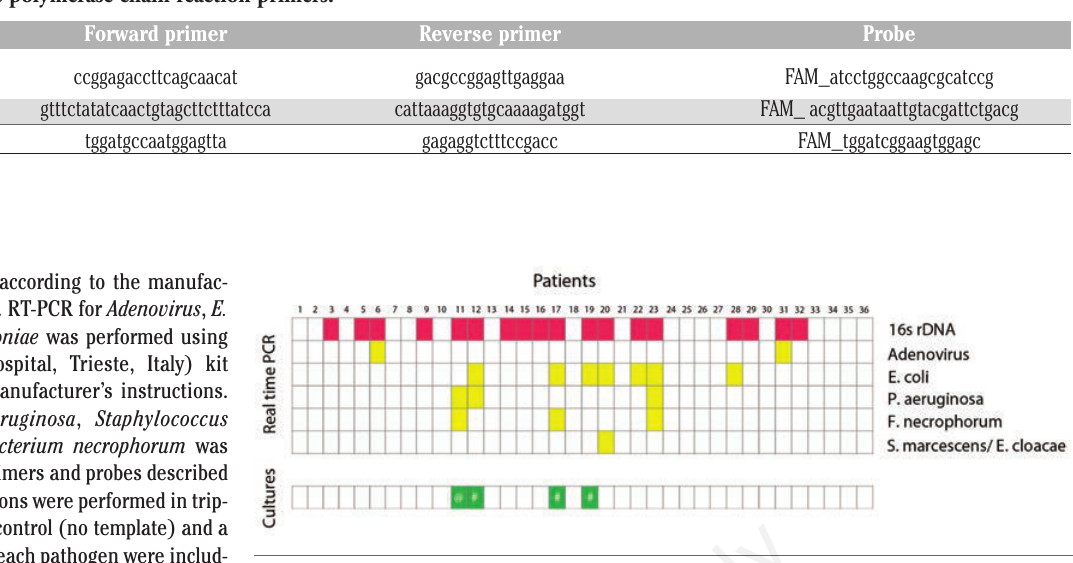
Figure 1. Results of real-time polymerase chain reaction (RT-PCR) analysis and cultures of specimens from 36 patients. Positive results are marked as blank squares. In three cul- tures (patient 12; 17; 19) grew E. coli at (#), in another one (patient 11) P. aeruginosa and B. ovale (@). Samples from these four patients resulted positive both to RT-PCR and cul-